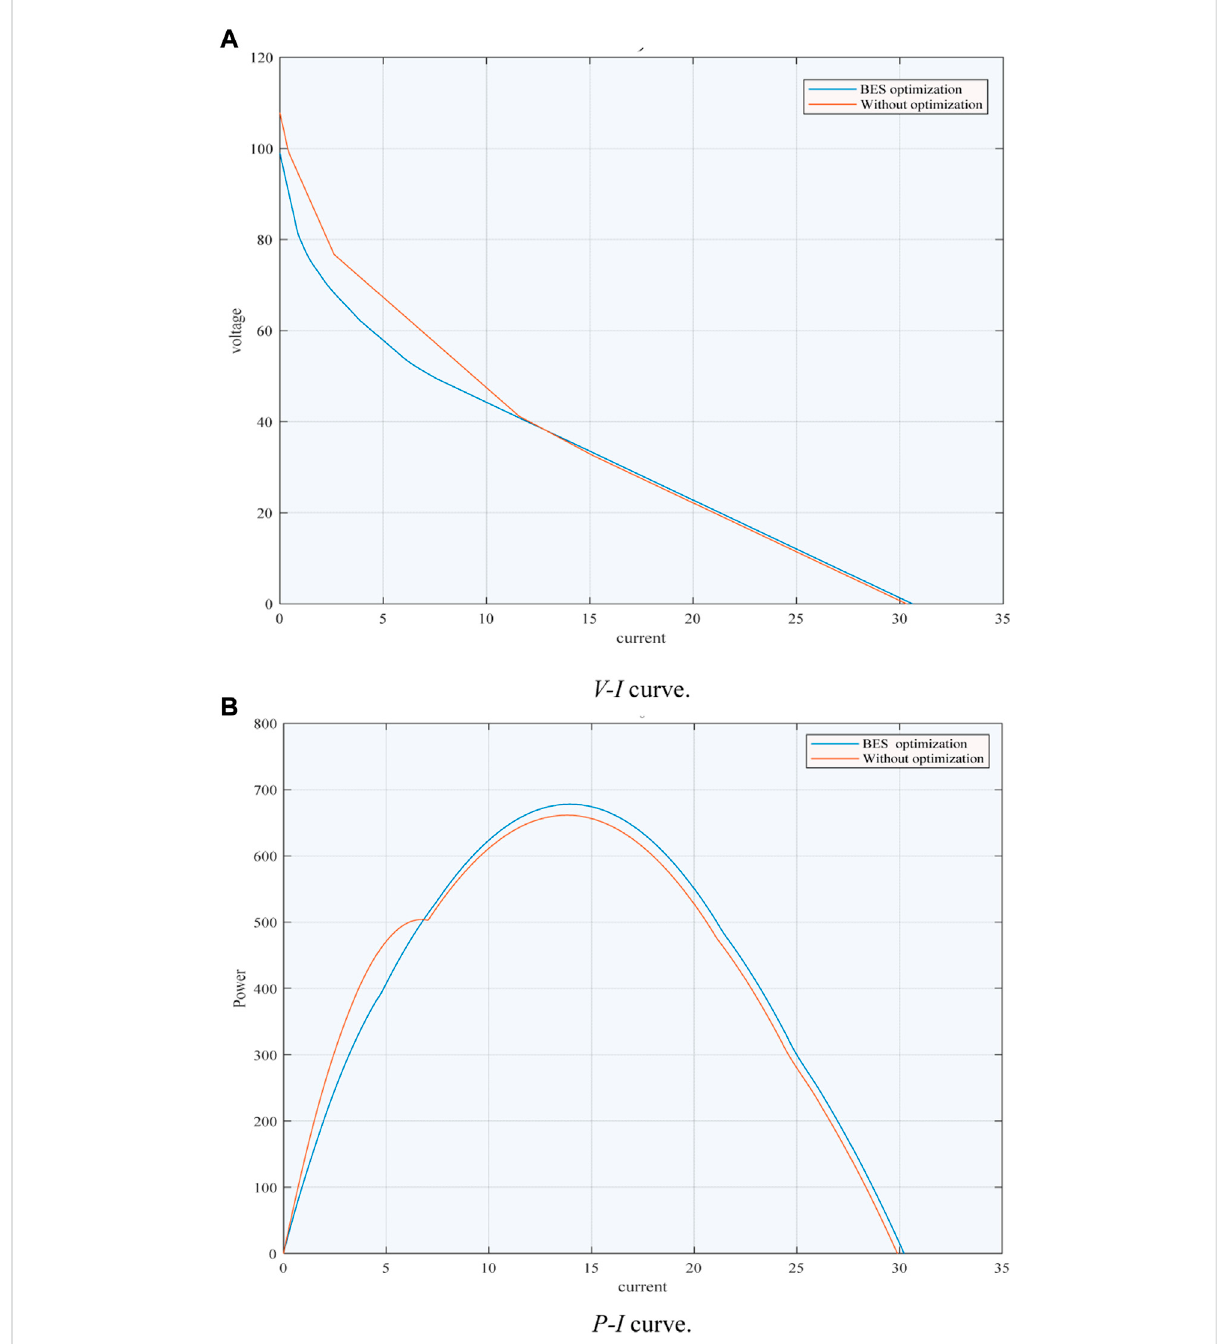
FIGURE 6 The V-I and P-I curves with and without the optimization. (A) V-I curve. (B) P-I